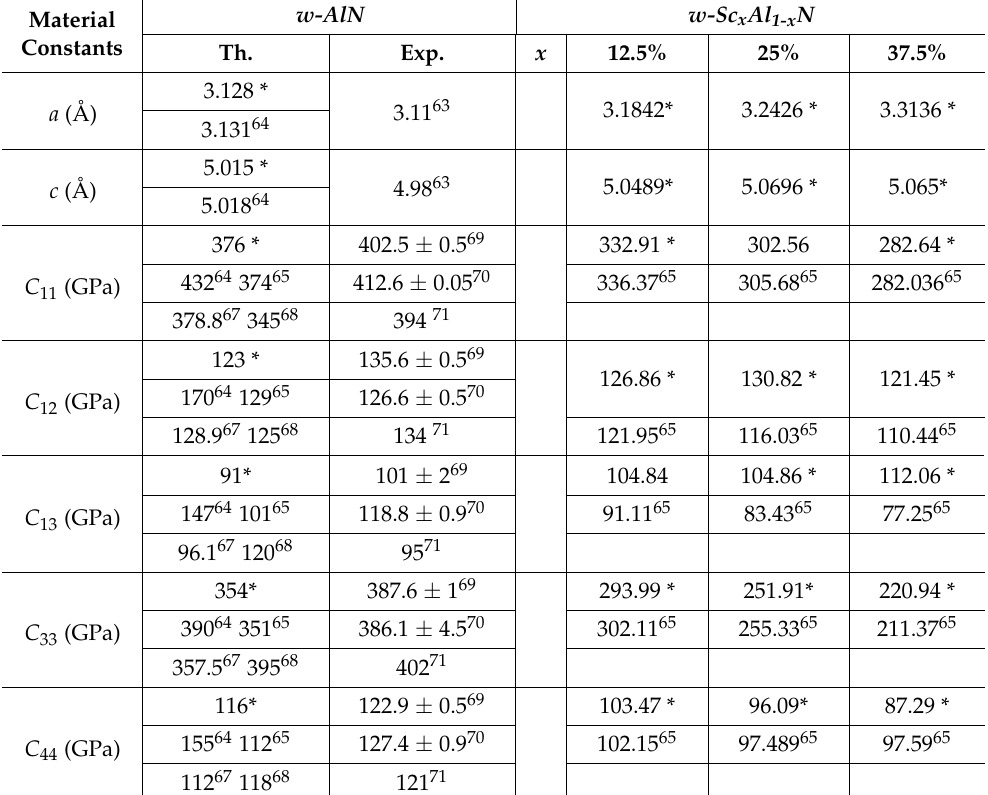
Table 1. Comparison of equilibrium lattice parameters ( a , c ) (Å) and elastic constants Cij (GPa)